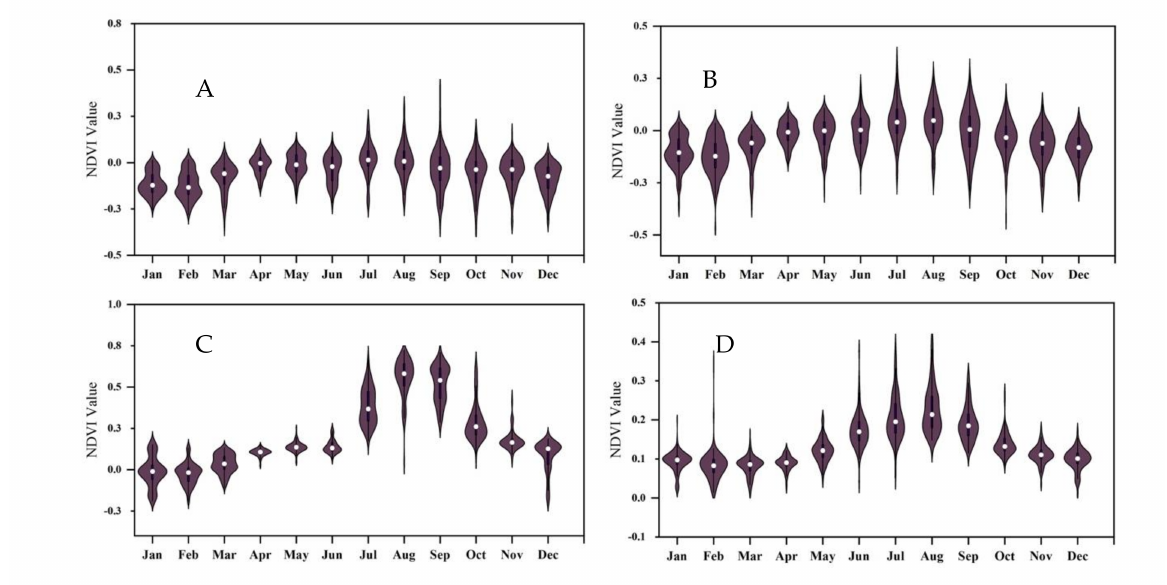
Figure 6. Inter-annual changes in the NDVI curves of different zones from the riverbed to the edge of the floodplain. ( A ) represents the continuously inundated floodplain area, ( B ) is the frequently inundated floodplain area, ( C ) represents the regularly inundated floodplain area and ( D ) represents the extremely rare inundated floodplain area.